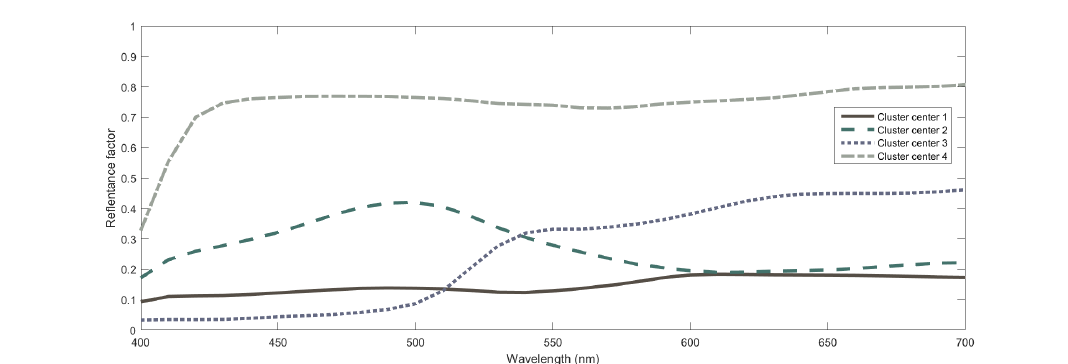
Figure 6. Spectral curves associated to cluster centers obtained in the FIS using CIEXYZ data. For each center, the curve is plotted using the RGB coordinates associated to the color represented by the curve itself for illustrative